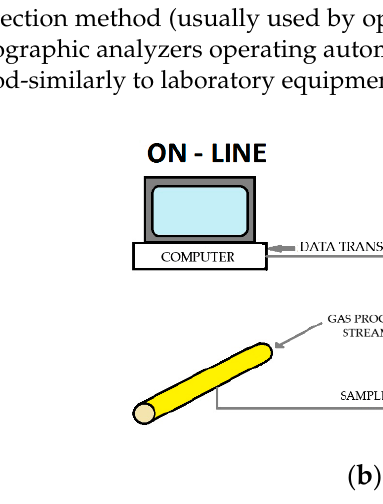
Figure 1. The operating principle of the: off ‐ line measurements carried out away from the gas pipe ‐ line, using a sample taken from the gas stream to the laboratory ( a ) and on ‐ line measurement system with a measuring device installed permanently or periodically at the sampling point ( b ).